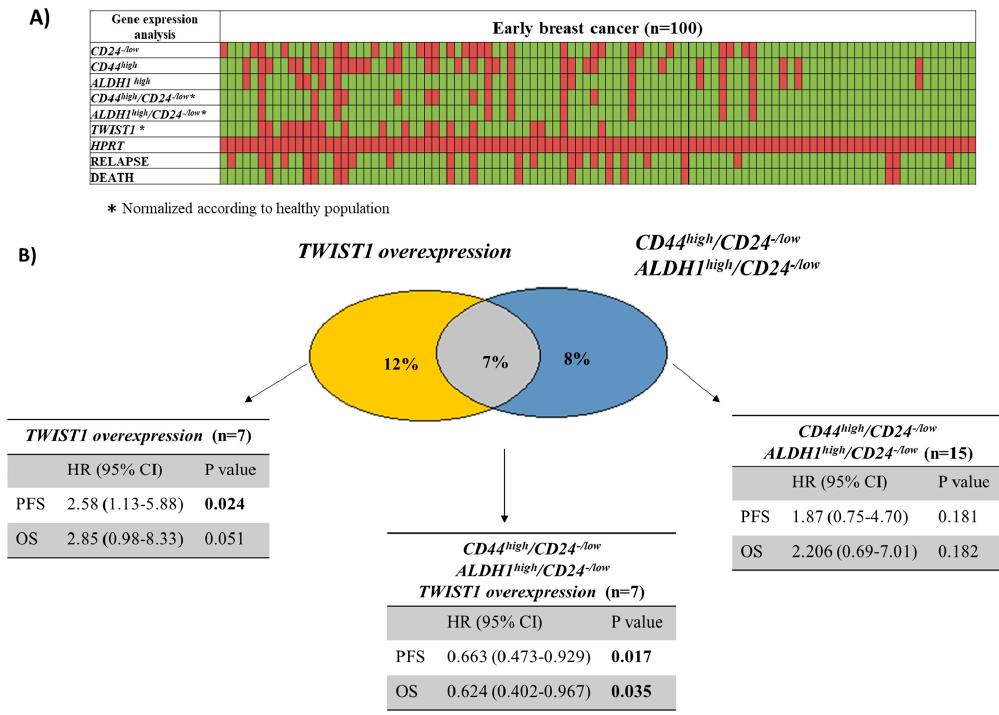
Figure 2. ( A ) Heat map of TWIST1 , CD24 , CD44 , and ALDH1 -mRNA quantification in the EpCAM+ CTC fraction from early stage breast cancer patients ( n = 100). Red color represents overexpression, while green color indicates underexpression or lack of expression. Concerning the relapse or death, red color represents the relapse or death, while green color indicates no relapse or alive status. ( B ) Univariate Cox-regression hazard models for TWIST1 overexpression, CD44 high /CD24 − /low , and ALDH1 high /CD24 − /low and the co-expression of the mesenchymal profile, TWIST1 , and the stem cell profile, CD44 high /CD24 − /low , and ALDH1 high /CD24 − /low .